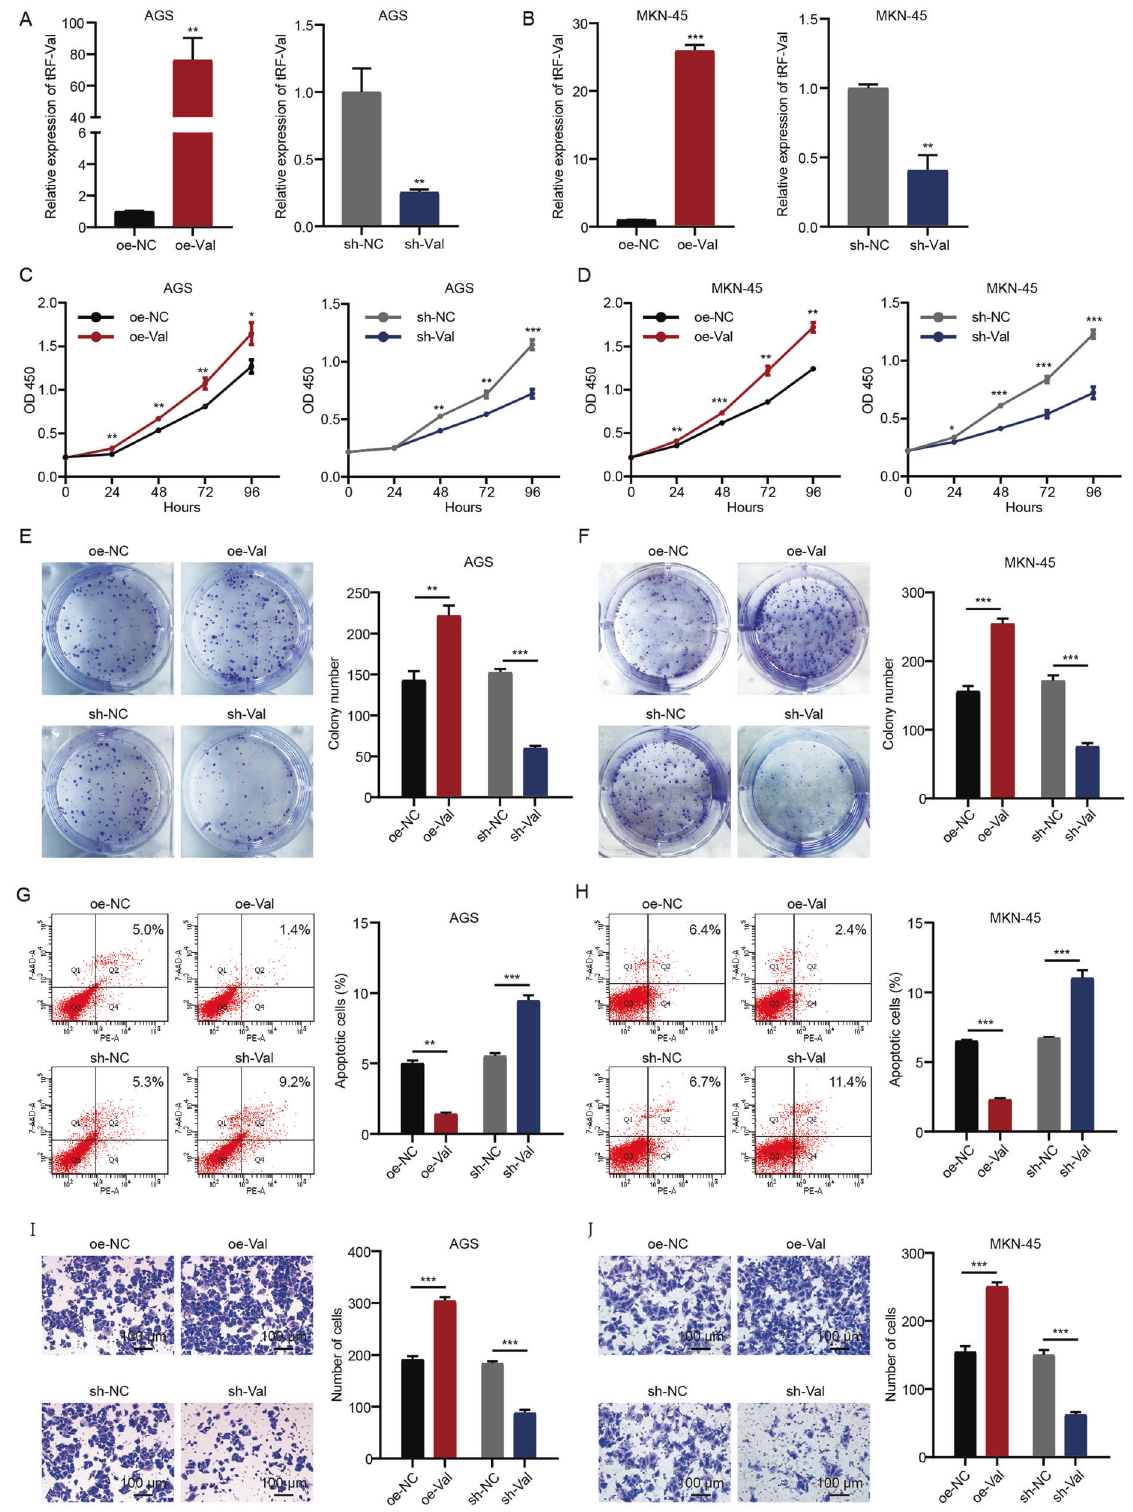
Fig. 3 tRF-Val promotes proliferation and invasion and inhibited apoptosis of GC cells in vitro. A , B The knockdown and overexpression ef fi ciencies of tRF-Val in AGS and MKN-45 cells were veri fi ed by qRT-PCR. C , D CCK-8 assay was performed to detect the proliferation of oe-NC, oe-Val, sh-NC, and sh-Val transfected AGS and MKN-45 cells. E , F Colony formation assay was performed to detect the proliferation of oe-NC, oe-Val, sh-NC, and sh-Val transfected AGS and MKN-45 cells. G , H Flow cytometry analysis was performed to detect the apoptosis of oe-NC, oe- Val, sh-NC, and sh-Val transfected AGS and MKN-45 cells. I , J Transwell assay was performed to detect the invasion of oe-NC, oe-Val, sh-NC, and sh-Val transfected AGS and MKN-45 cells. The scale bar, 100 μ m. Data were shown as mean ± SD. (Student ’ s t -test, * P < 0.05, ** P < 0.01, and *** P < 0.001). NC means negative control, sh means short hairpin RNA, Val means tRF-Val, and oe means overexpression.